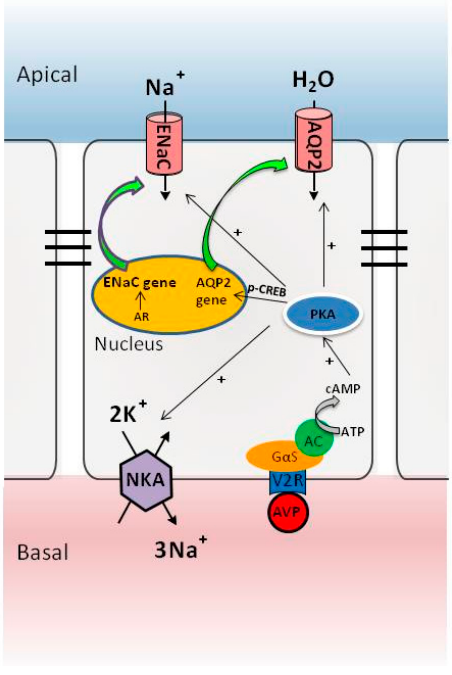
Figure 1. The arginine vasopressin (AVP)-V2 receptor system in controlling water and sodium reabsorption in renal collecting ducts. AR, aldosterone receptor; NKA, Na + -K + -ATPase; +, activation.